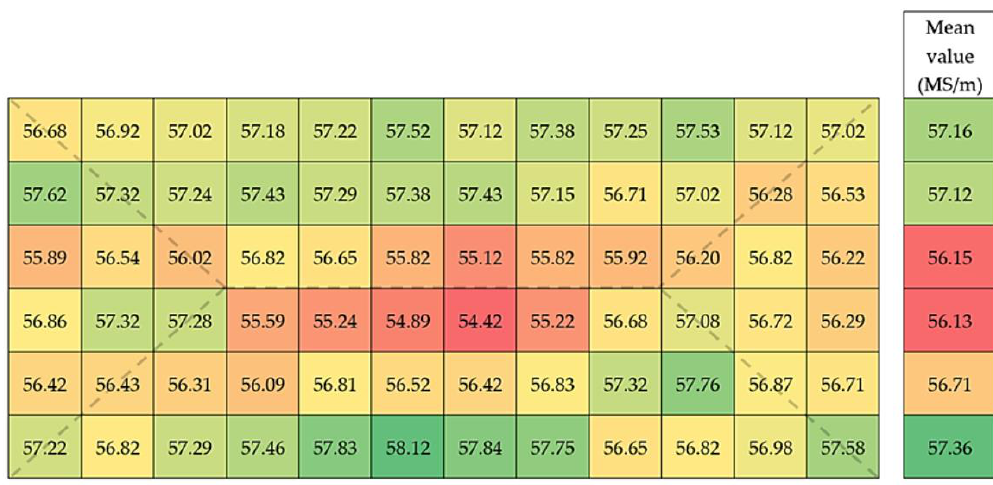
Figure 5. Electrical conductivity at the cross section of ETP grade copper strand with marked crystallization